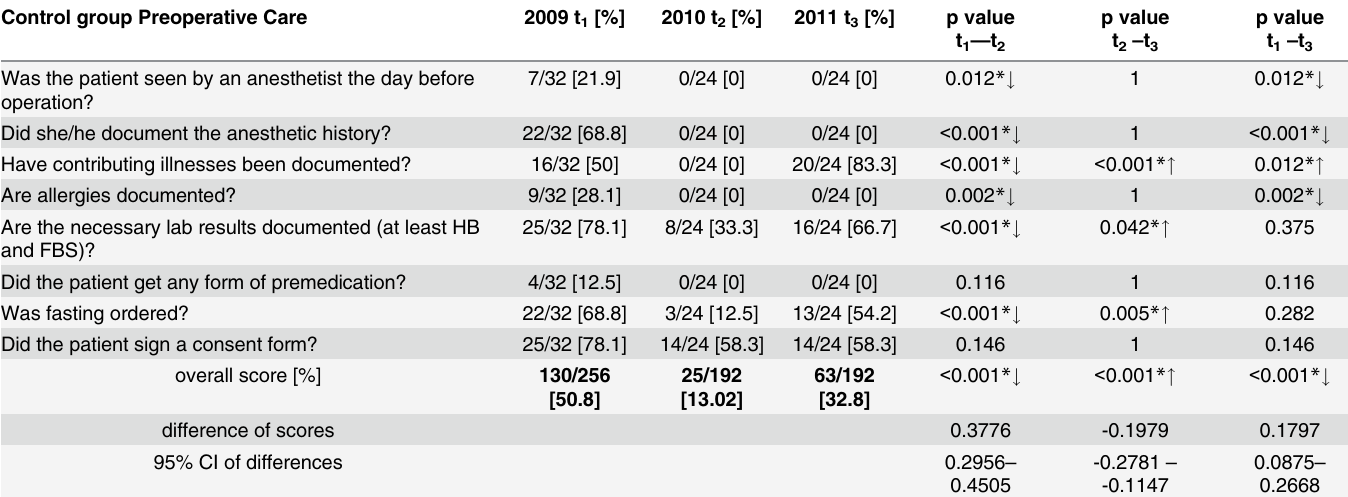
Table 5. Immediate outcome indicators for Preoperative Care in the Control Group 2009 to